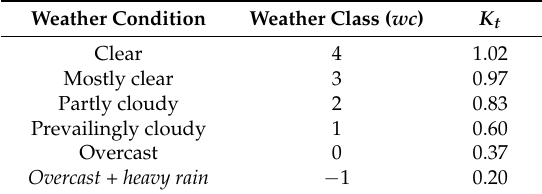
Table 1. Weather data and average clearness indexes for the selected weather